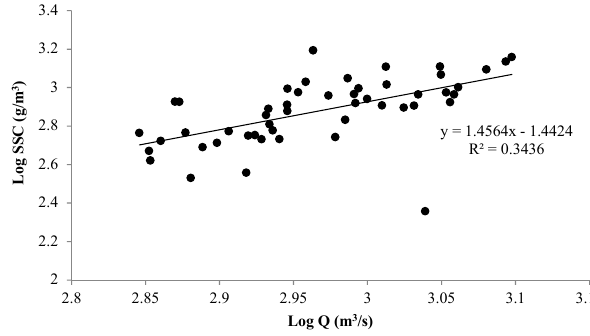
Figure 3. Rating curve for the Jiuzhou Station.